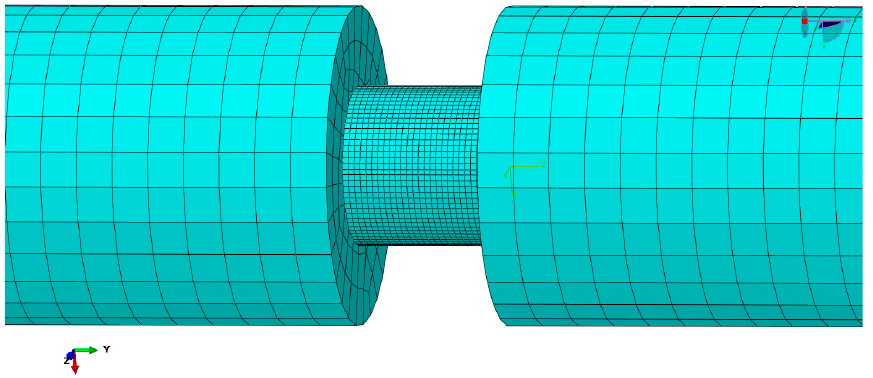
Figure 5. Setting of constraints and contacts.